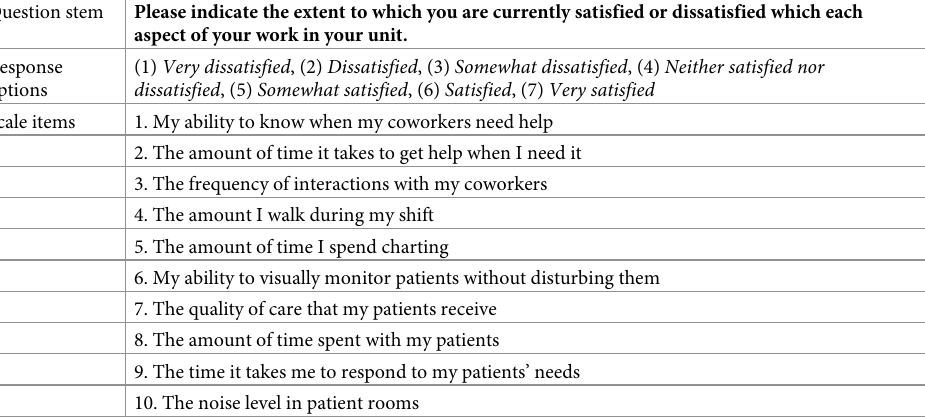
Table 1. Initial survey instrument used in the initial pilot survey phase. Question